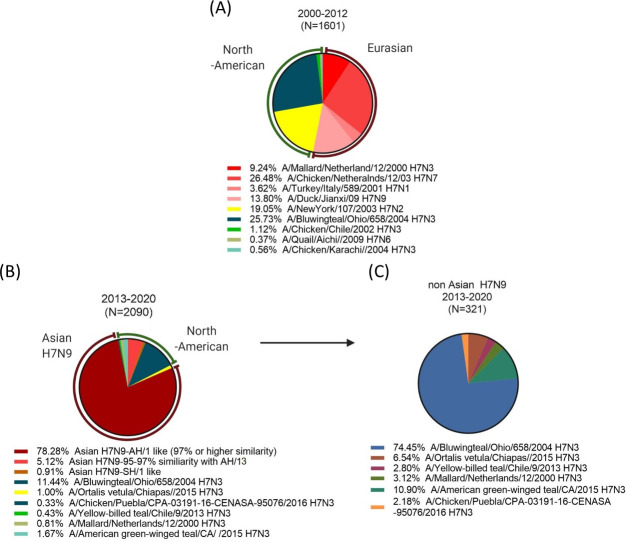
Frequencies of influenza HA clusters in 2000 and 2018.Total of 3633 Influenza HA sequences uploaded between 2000 and 2018 in GISAID databases were aligned to understand how the H7Nx viruses evolved. Due to the overwhelming number of Anhui/13-like viruses during Asian H7N9 epidemics, the pie chart analysis was separately conducted on sequences isolated before and after 2013 Asian H7N9 epidemics (A and B). The non-Asian H7N9 sequences isolated after 2013–2018 were further analyzed as a separate pie (C). The aligned sequences were clustered by 3% amino acid similarity and dissected into each pie. The viruses to represent each pie were chosen from WHO candidate vaccine viruses.